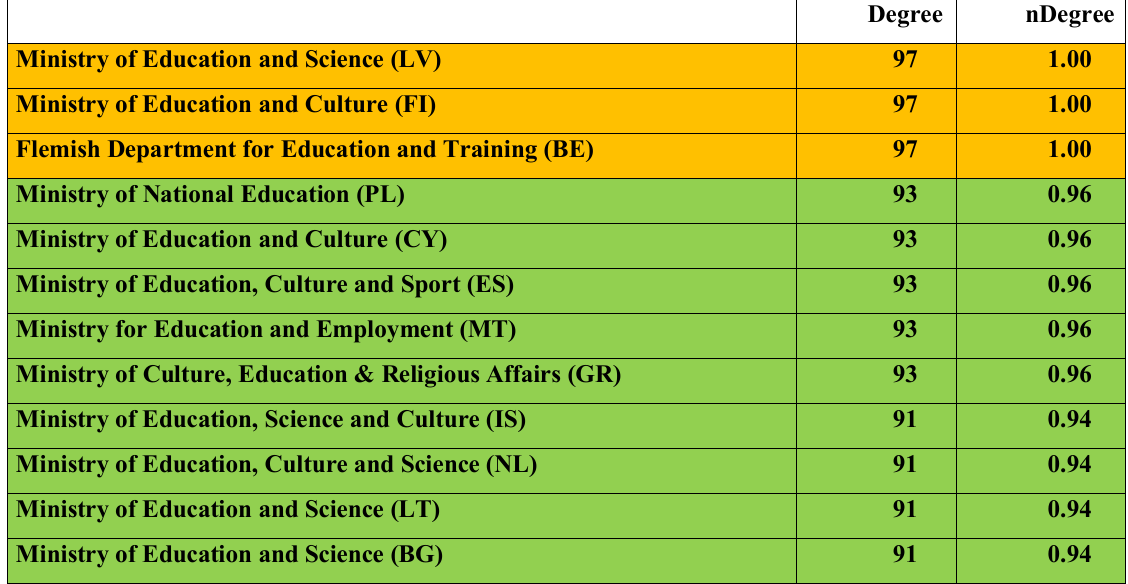
Table 2 – The level of centrality: Degree and nDegree